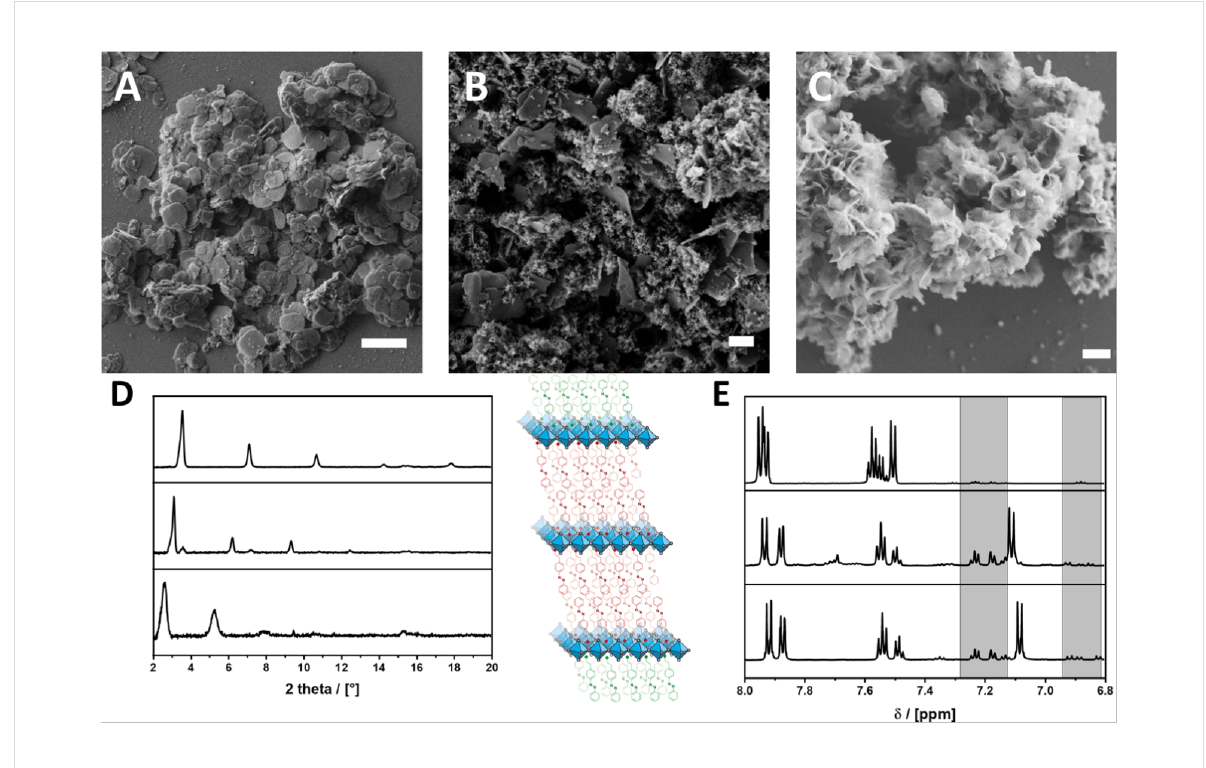
Figure 2: (A) SEM image of 2D-AzoC 2 , (B) SEM image of 2D-AzoOC 4 , (C) SEM image of 2D-AzoOC 12 , scale bar = 1 µm. (D) Powder X-ray diffrac- tion (PXRD) pattern of the 2D LHPs with incorporated AzoC 2 , AzoOC 4 and AzoOC 12 with a layer thickness of d (001) = 2.48 nm, d (001) = 2.84 nm and d (001) = 3.40 nm, respectively (from top to bottom). (E) 1 H NMR spectra in the aromatic region from 8 to 6.8 ppm of 2D-AzoC 2 , 2D-AzoOC 4 and 2D-AzoOC 12 (from top to bottom), which were first dispersed in toluene, irradiated at 313 nm for 600 s, dried and dissolved in MeOD. Signals of the cis -isomers are highlighted in grey. The scheme shows the two types of azobenzene ligands in the 2D systems, i.e., molecules incorporated into the layers and species bound to the exterior surface of the